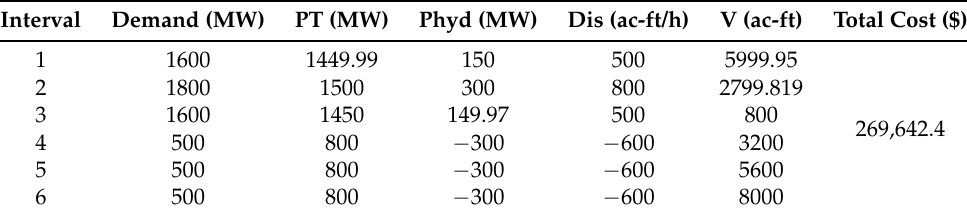
Table 4. Power flow and cost optimization with the improved APSO algorithm implementation on the non-cascaded pumped storage STHTS problem.